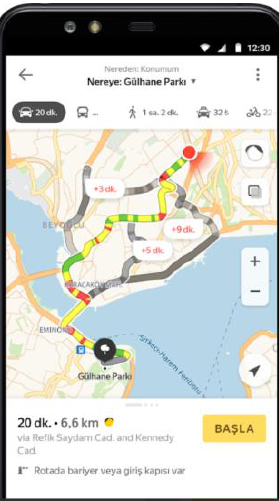
Figure 11 . Alternative route suggestion based on traffic density in Yandex Maps